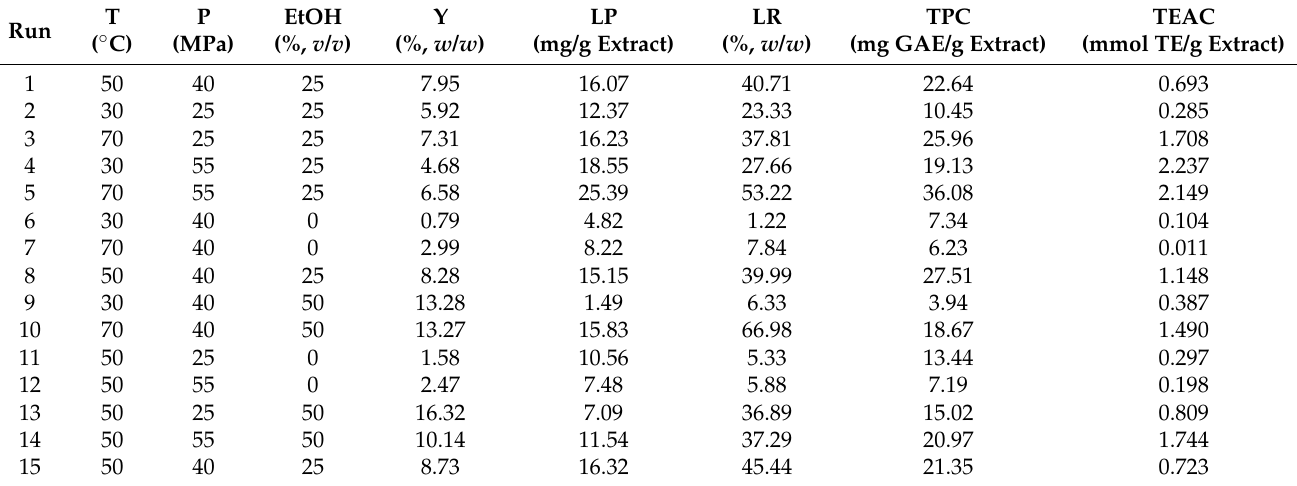
Table 2. Extraction yields (Y), lutein purity (LP), lutein recovery (LR), total phenol content (TPC), and antioxidant activity (Trolox equivalents antioxidant capacity (TEAC)) by supercritical fluid extraction from the acidophilic eukaryotic microalga Coccomyxa onubensis using the Box–Behnken experimental design. The general parameters are biomass loading = 2.0 g, CO 2 flow rate = 3.62 g/min, and extraction time = 60